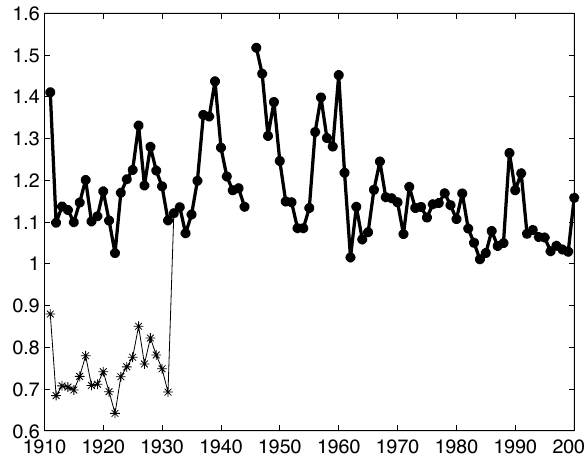
Fig. 5. Ratio of the corrected annual IHV-raw values between ESK and NGK (thick line with dots). For comparison the uncorrected ratio is also shown (thin line with stars). The step from 1931 to 1932 is seen before but not after